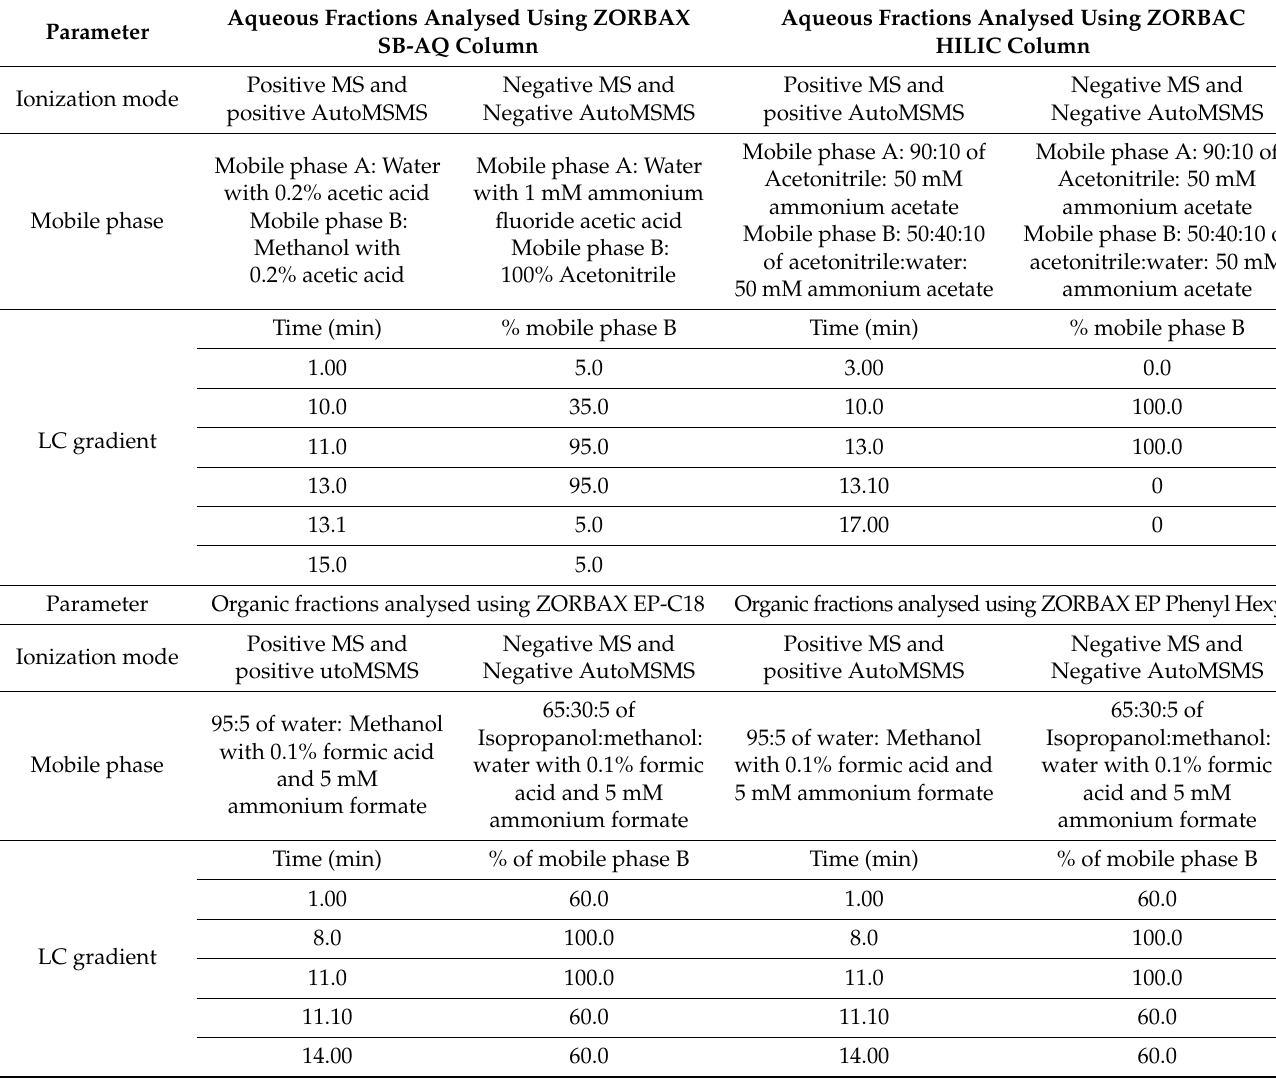
Table 2. Chromatographic parameters used in the LC/MS and LC-MS/MS